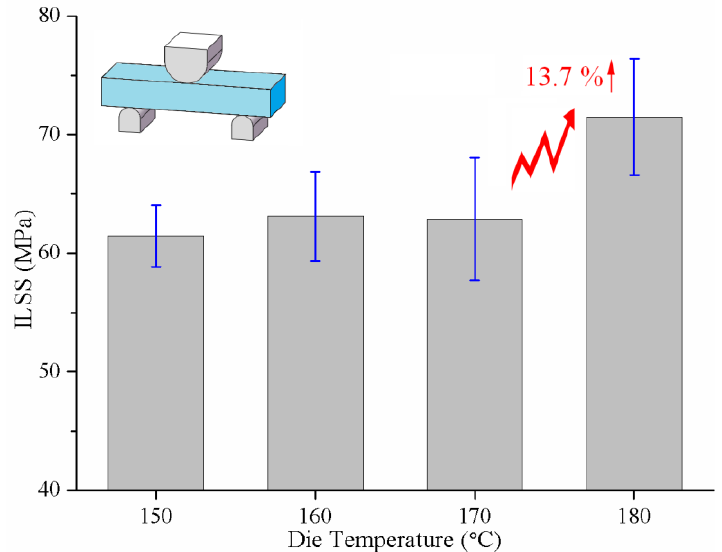
Figure 11. The interlaminar shear strength of the pultruded composites depending on heating zone temperature.